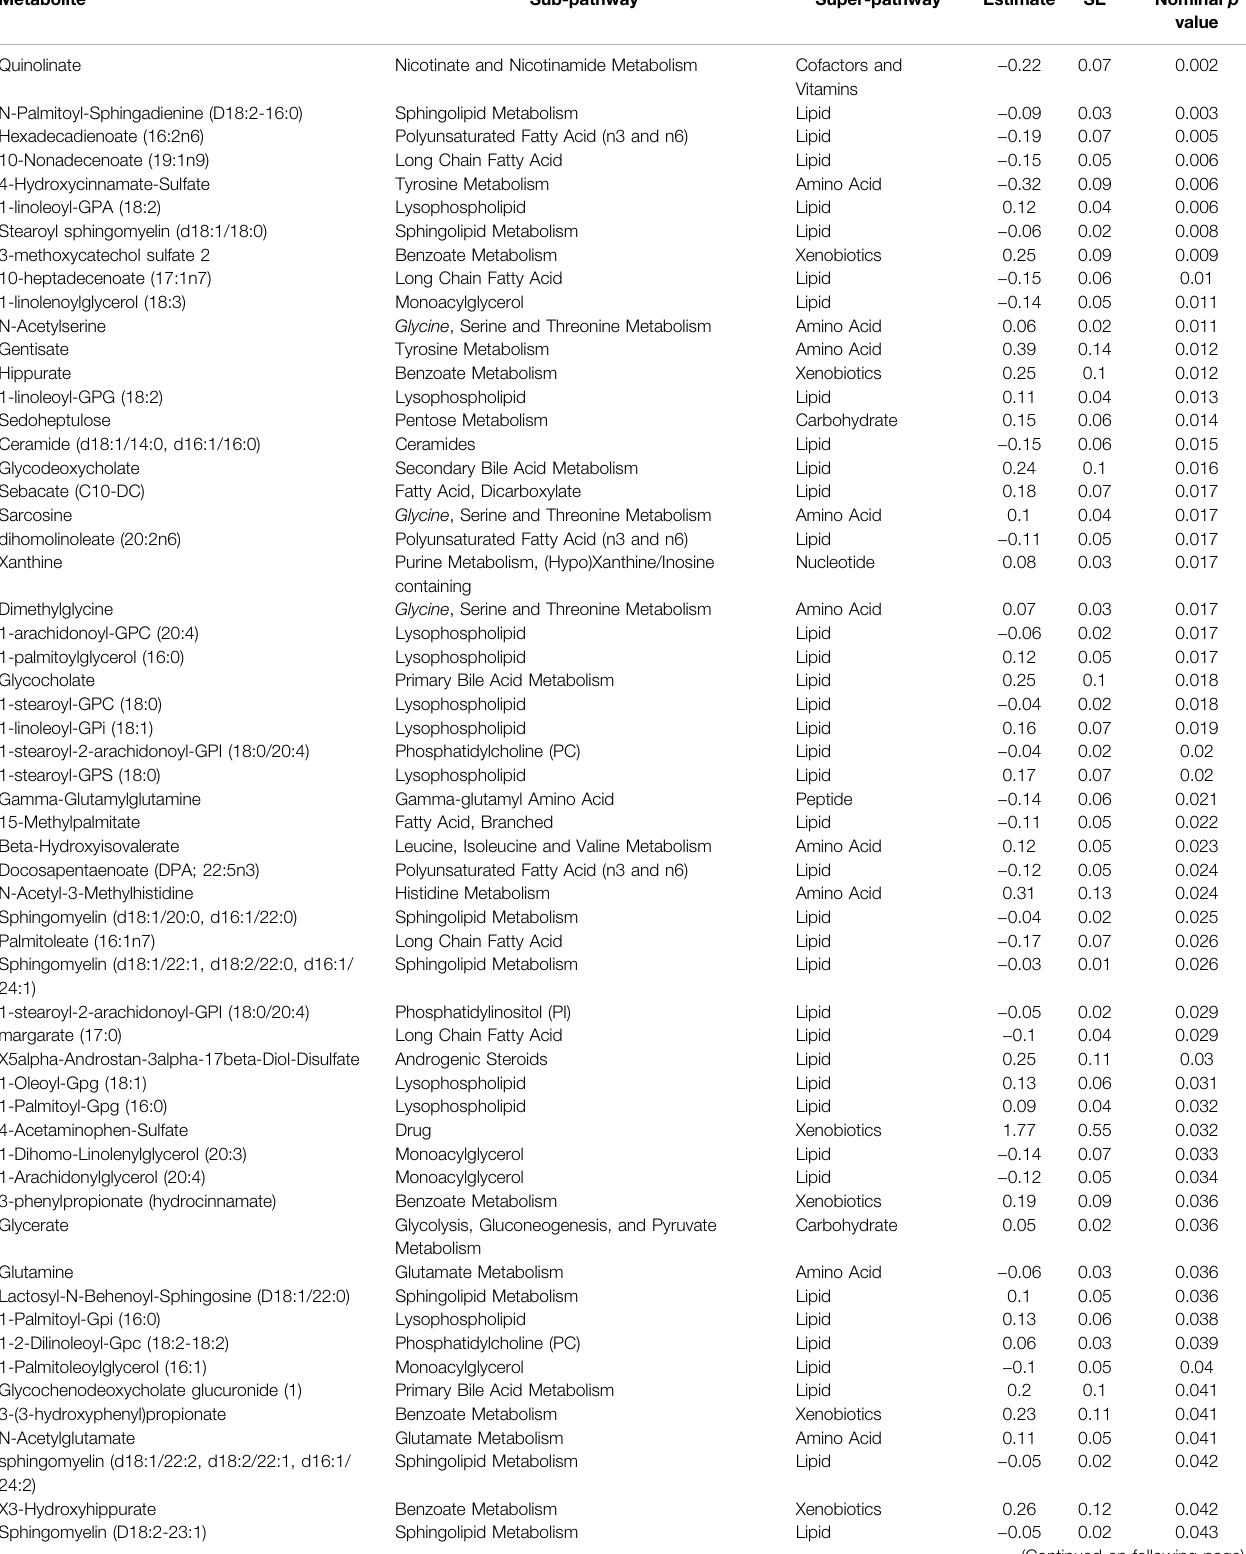
TABLE 1 | Metabolites associated with TL after correcting for PCs and